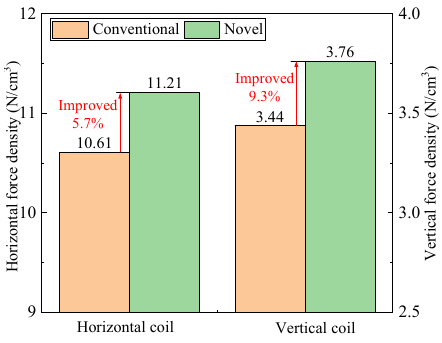
Figure 22. Comparison of driving force density of two models.